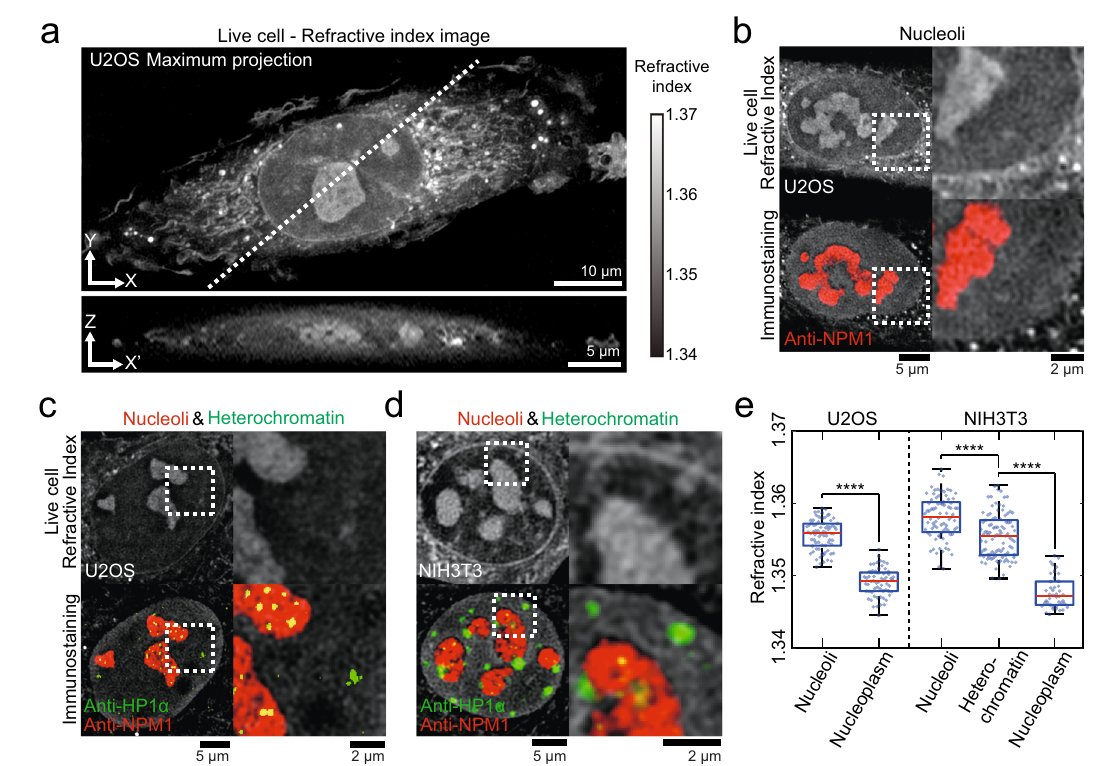
Fig. 1 | Quantitative refractive index imaging of intracellular condensates. a (Top)Maximumintensityprojectionofthe3DRItomogramofanintactliveU2OS cell. (Bottom) Cross-sectional view of the same cell along a white dashed line. b – d (Top row) RI images of intact live cells. (Bottom row) Combined RI and immuno fl uorescence images of the same cell after fi xation. The dashed boxes indicateareasforzoomed-inimagesontheright. b RIimagesofanintactliveU2OS cellandthesamecellafterimmunostainingwithanti-NPM1. c RIimagesofanintact live U2OS cell and the same cell after double-immunostaining with anti-NPM1 and anti-HP1 α . d RI images of an intact live NIH3T3 cell and the same cell after double-